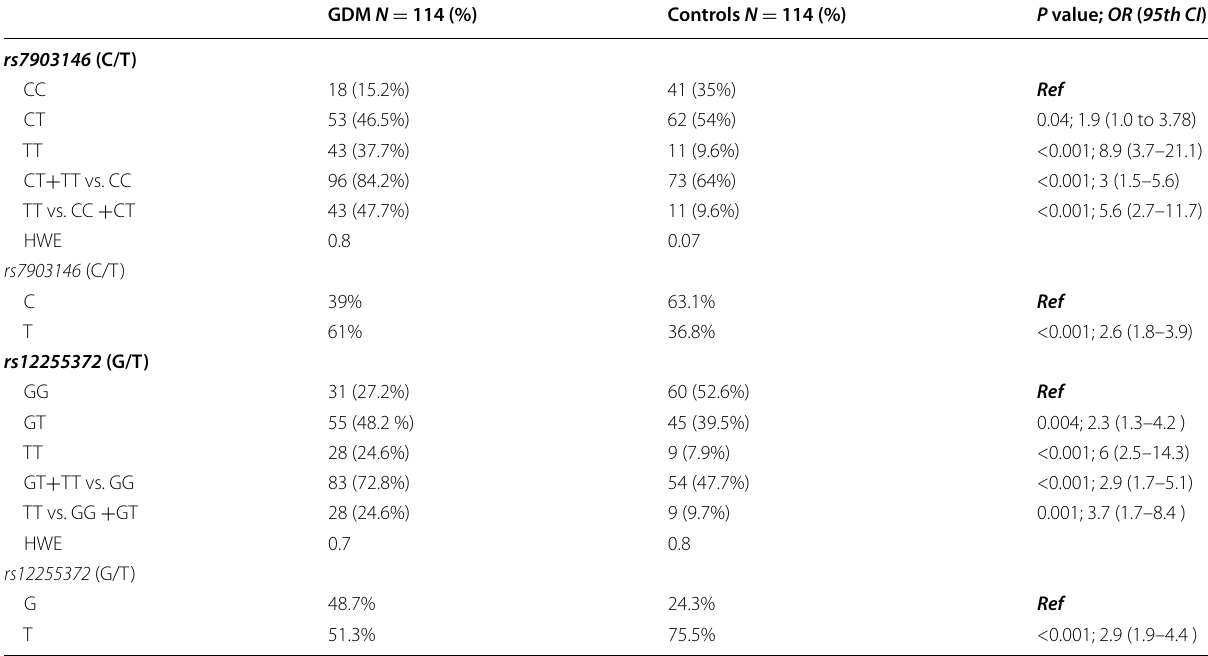
Table 3 TCF7L2 genotyping and allele frequencies for GDM cases and